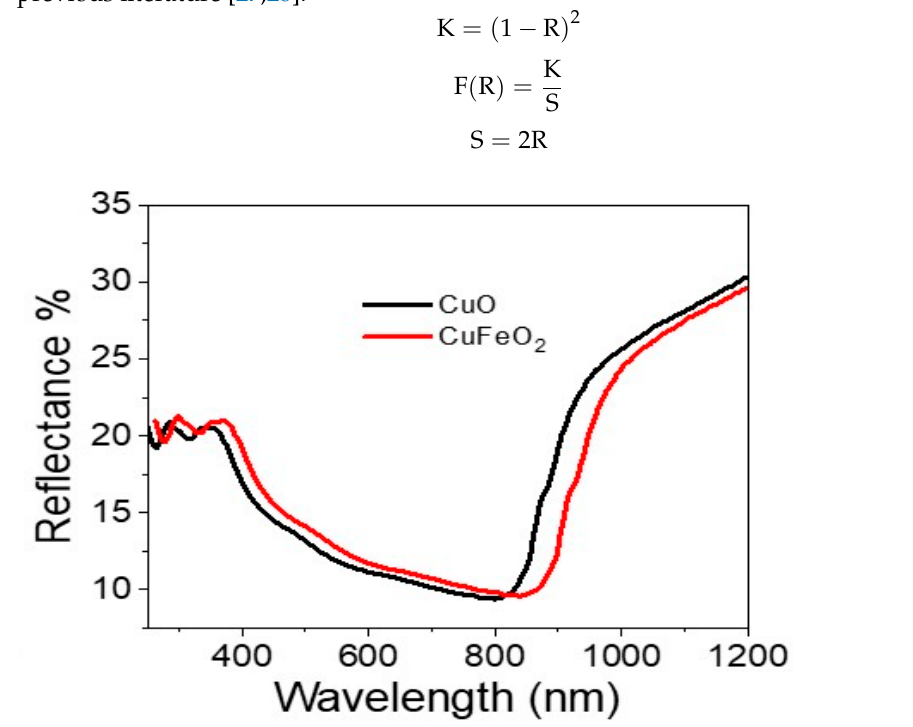
Figure 4. The reflectance of CuO and CuFeO 2 materials.